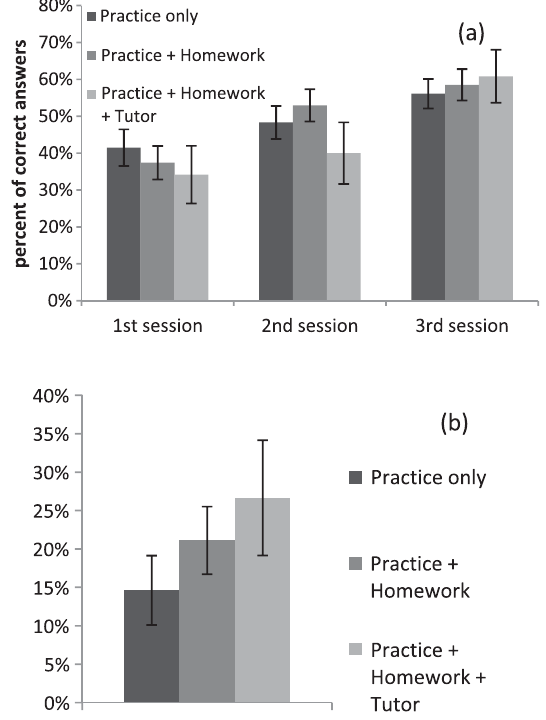
FIG. 3. (a) Practice exam scores. (b) Practice exam score changes between the first and third